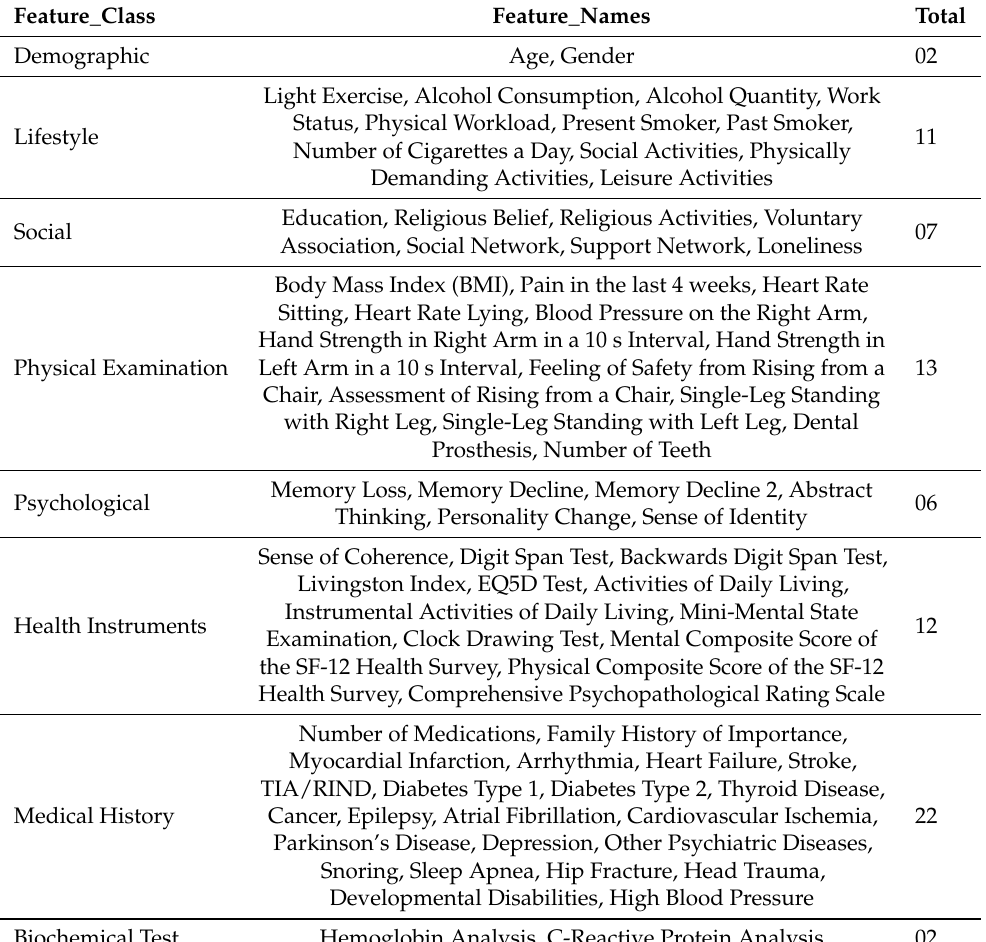
Table 2. Overview of features in the